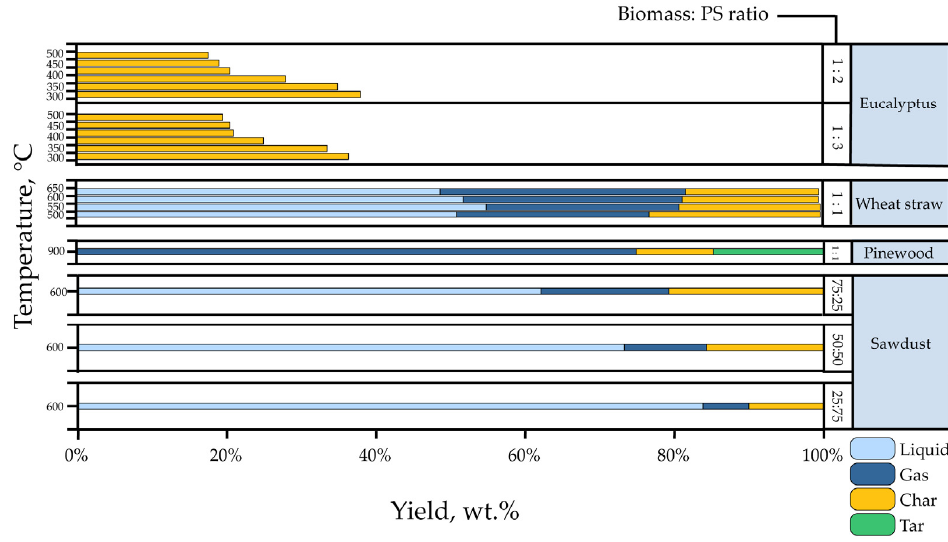
Figure 11. Co-pyrolysis of PS and various biomass